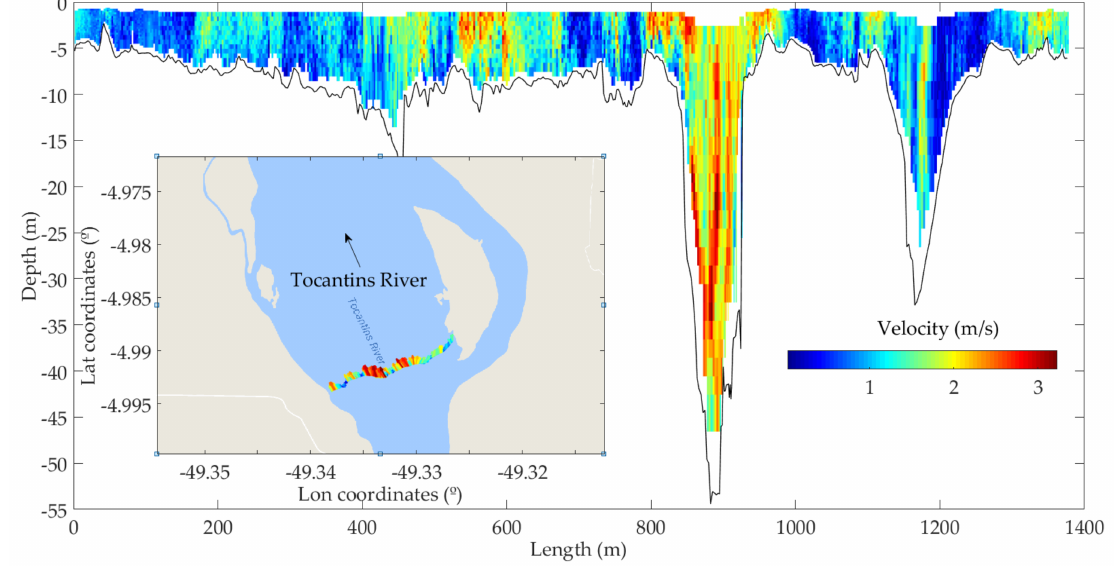
Figure 5. Flow velocity profiles over a full cross-section (3D Velocity magnitude) (April